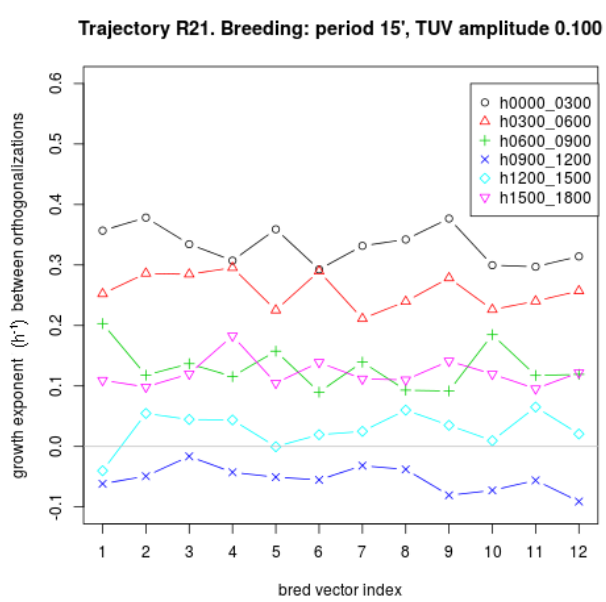
Figure 2. Growth rates of the 12 bred vectors at different forecast times, as a function of the bred vector index (the growth rate has been averaged over 3h intervals, as indicated in the legend box). Different colours refer to different forecast times. As indicated in the panel titles, the BVs are constructed differently for trajectory 18H (large initial error, top panel) and for trajectory R21 (small initial error, bottom